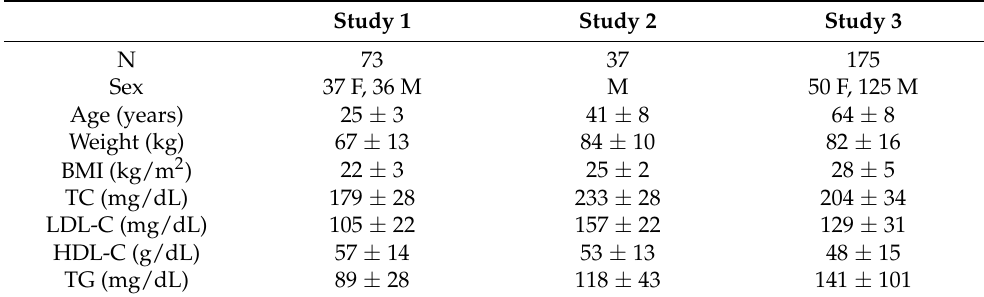
Table 1. Subject characteristics of the three study populations. The data are expressed as number of subjects or as mean ± standard deviation. TC = total cholesterol, LDL-C =low density lipoprotein